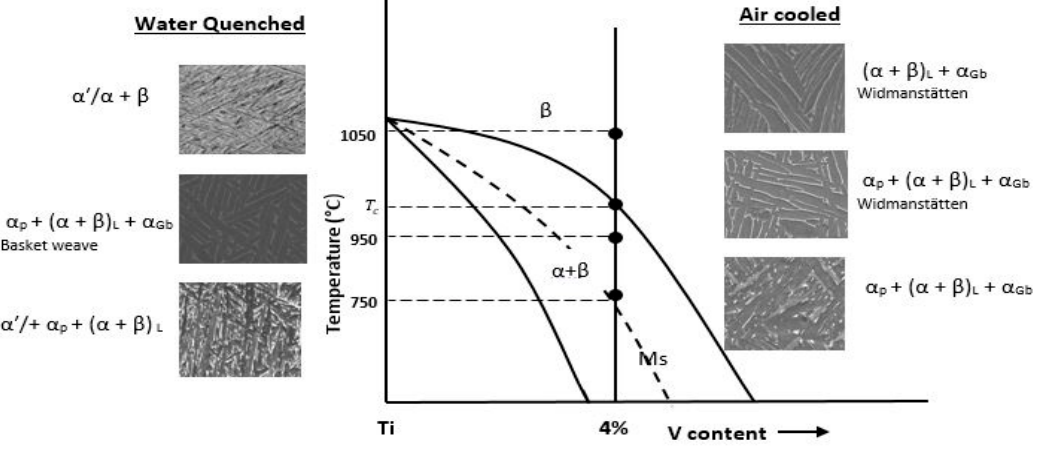
Figure 2. The Ti6Al4V phase transformation diagram, resultant phases and typical morphology of microstructures formed after water quenching and air cooling.